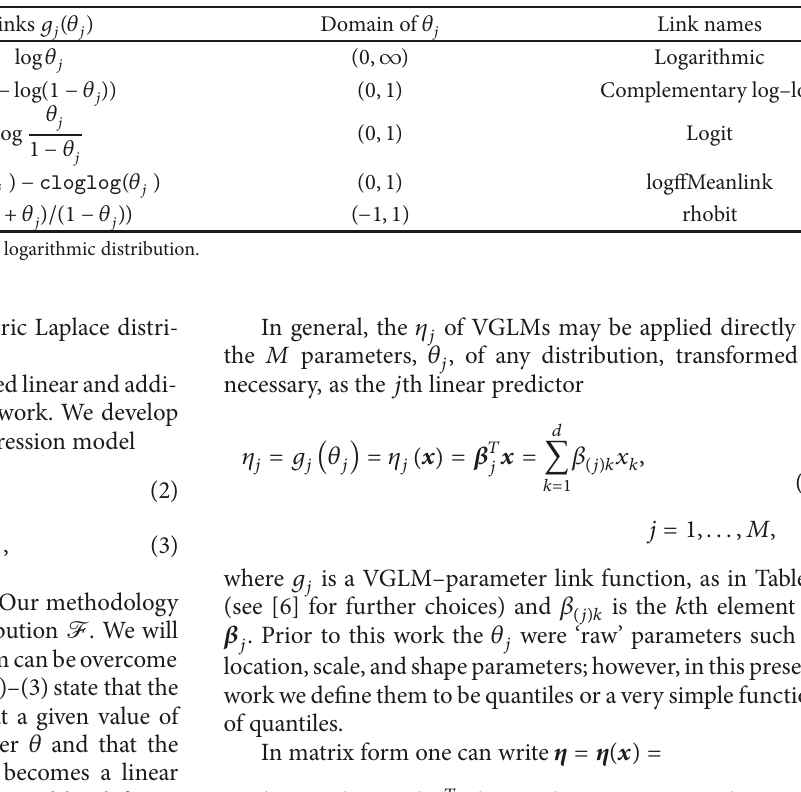
Table 1: Some VGLM/VGAM link functions. The 4th row is implemented in VGAMextra